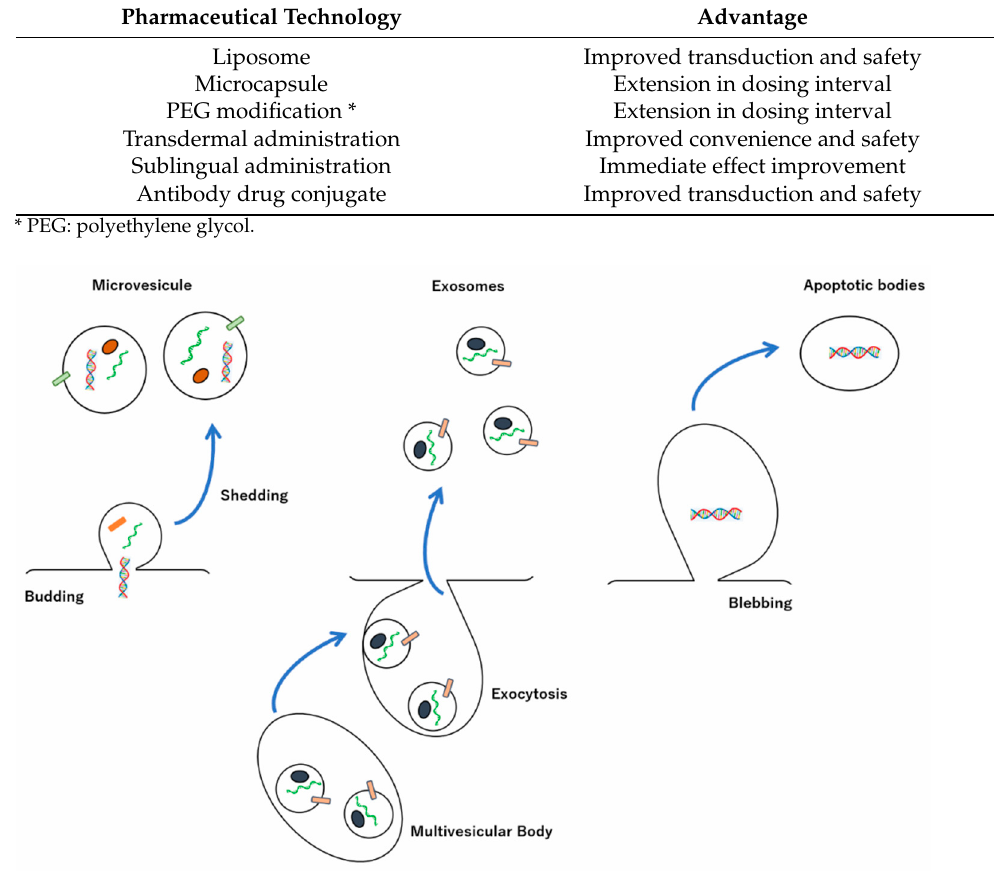
Figure 1. Secretions of extracellular vesicles (EVs). EVs are divided into three main populations according to their diameters: exosomes at 30 to 150 nm, microvesicles (MVs) at 100 to 1000 nm, and apoptotic bodies at 50 to 5000 nm. The exosome biogenesis involves the formation of multivesicular bodies and transfer to the plasma membrane, where the exosomal contents, proteins, and miRNAs are released via their fusion. The formation of both MVs and apoptotic bodies is accompanied by budding and blebbing of the cell membrane to pinch off new vesicles, respectively.